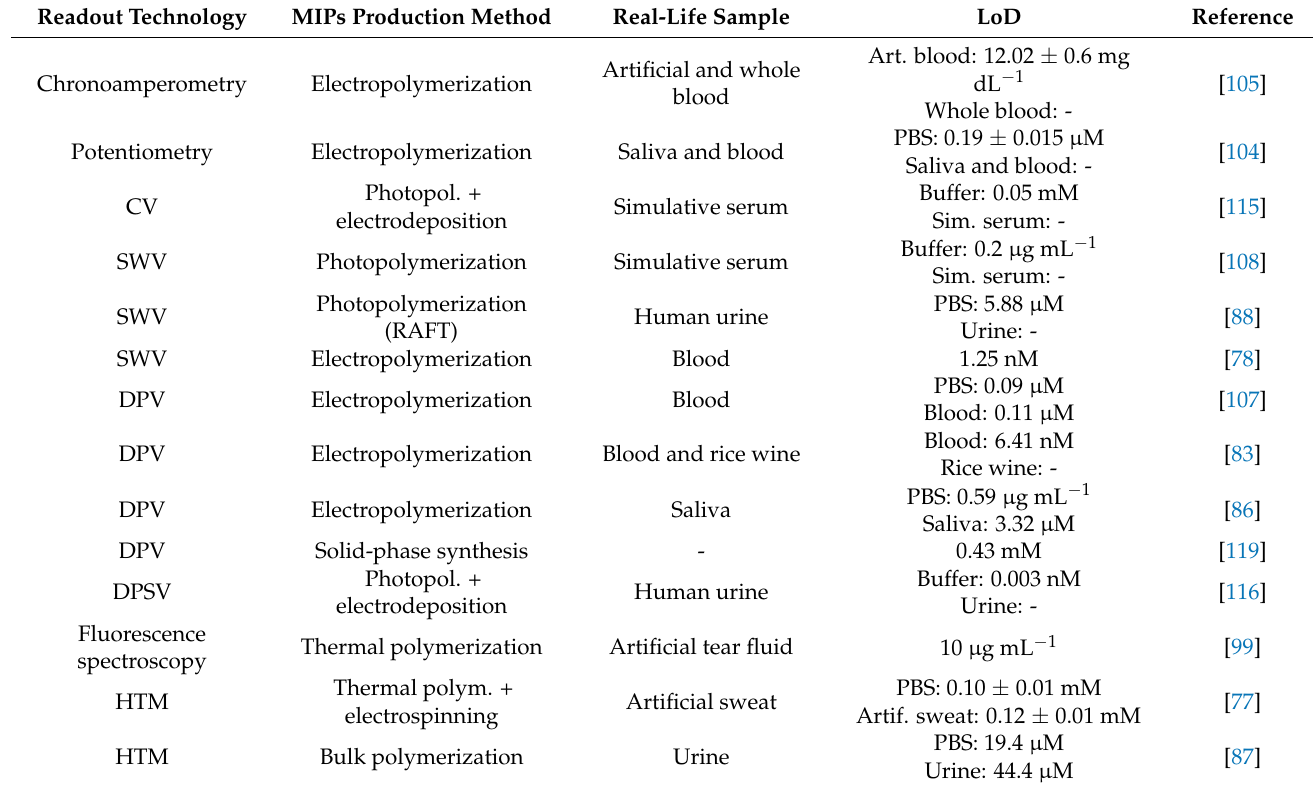
Table 4. Overview of promising MIP technologies for glucose